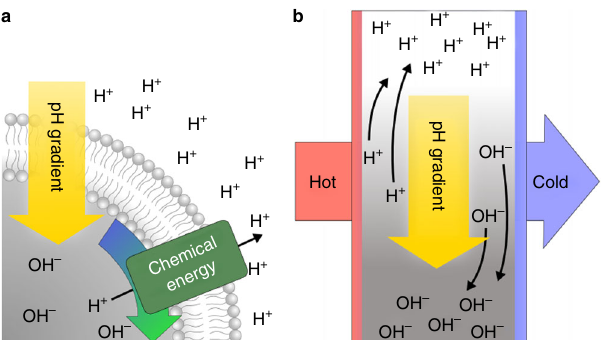
Fig. 1 Formation of pH gradients by chemical or thermal energy. a Modern cells run on an elaborate protein system to maintain proton gradients across a membrane. Chemical energy is used to pump protons against their concentration gradient which is then harnessed by chemiosmosis. b Heat fl uxes across con fi ned solutions, a common geological setting, induce a movement of ions that results in a stable pH gradient of up to 2 pH